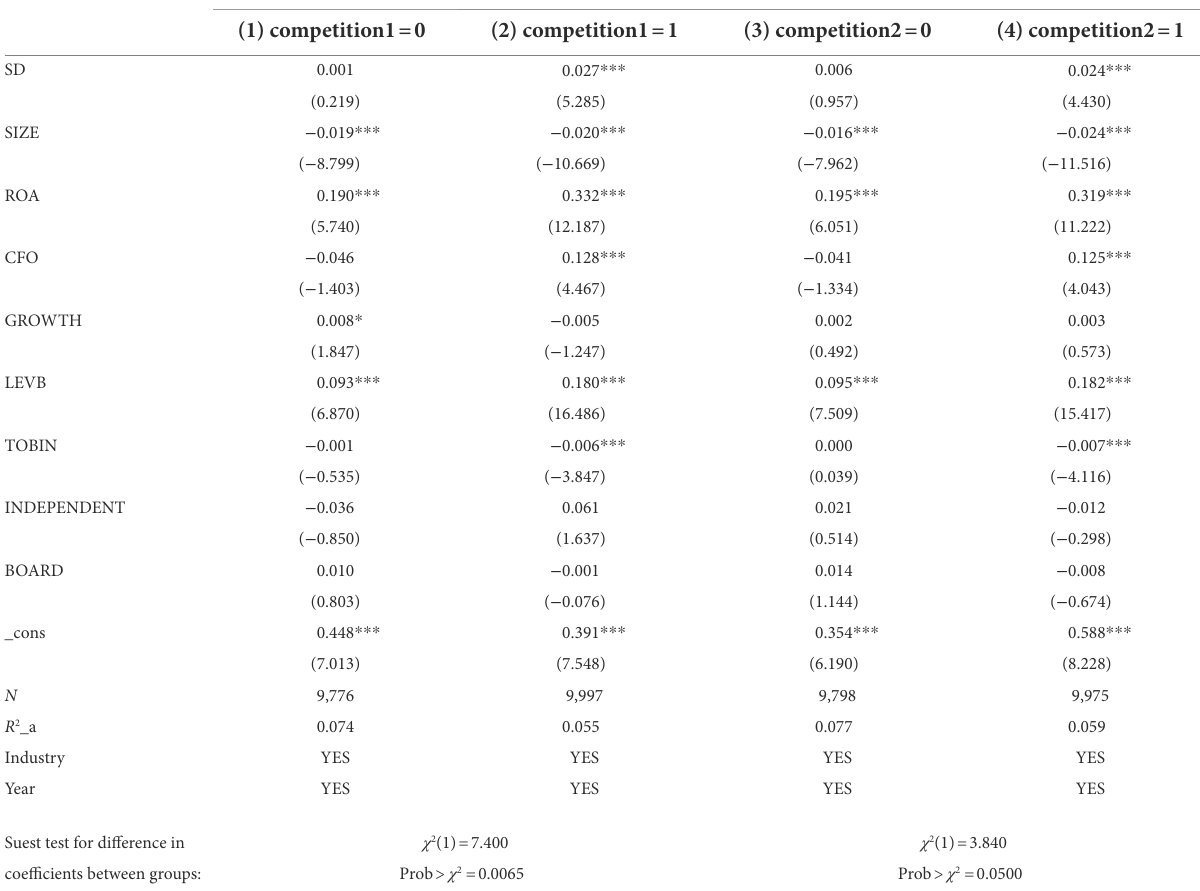
TABLE 6 Industry product market competition, strategic differentiation, and firm leverage